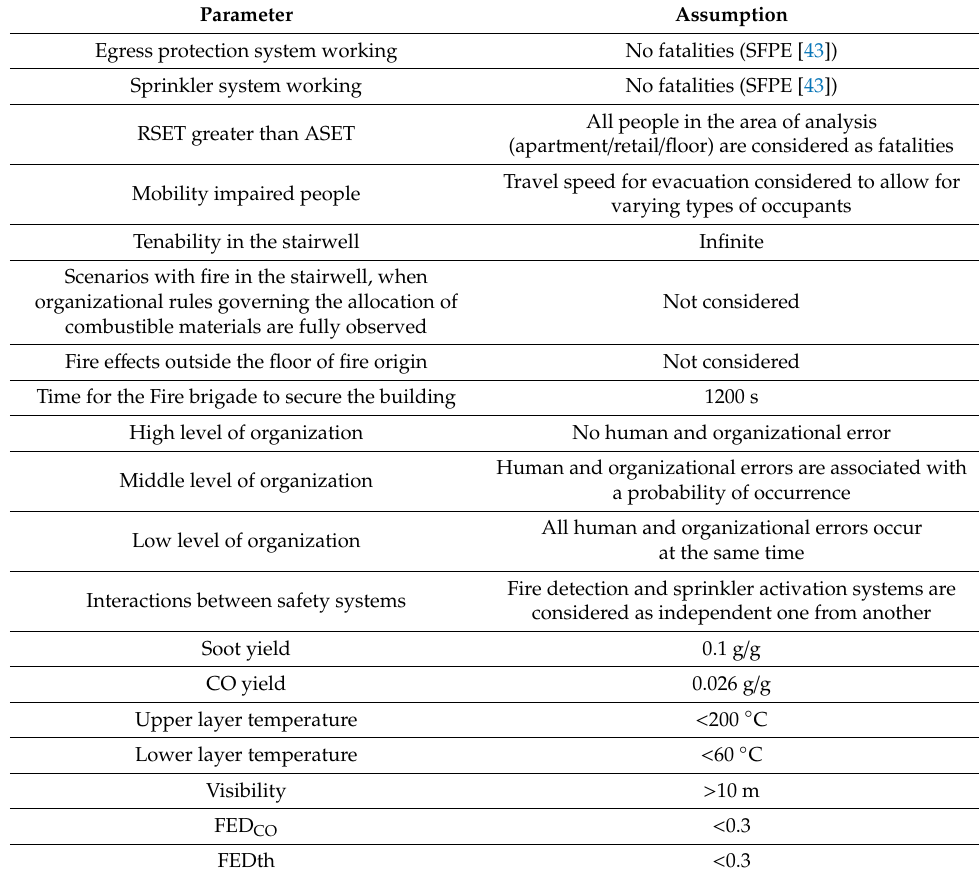
Table 6. Assumptions applied to the four case studies.